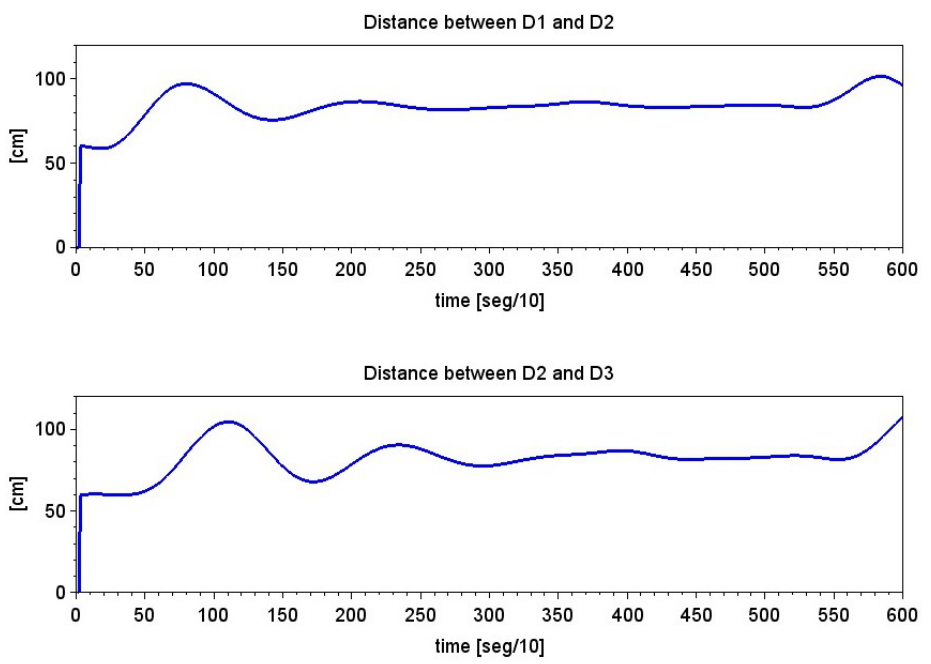
Figure 12. Euclidean distance along time between each pair of drones transporting the DLO in Experiment 1 without wind